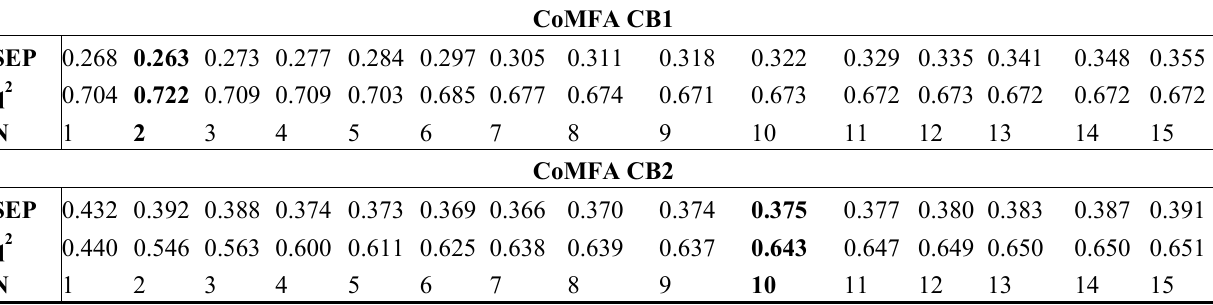
Table 4. Optimum number of components analysis a